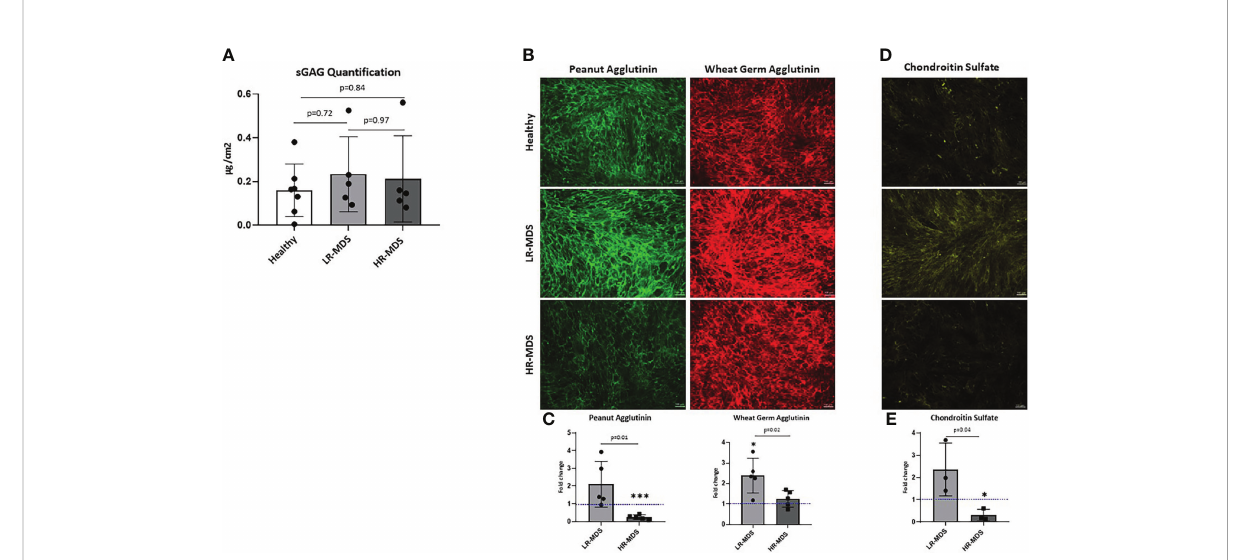
FIGURE 2 Analysis of N -acetyl-glucosamine and N -acetyl-galactosamine GAGs as well as of CS in ECM. (A) Quanti fi cation of sulfated GAGs of ECM from healthy donor, LR-MDS and HR-MDS MSC using Blyscan assay. (B) Representative images from the lectin staining using Wheat germ agglutinin (green) which binds to N -acetyl-glucosamine GAGs (HA, heparan sulfate and keratan sulfate) and sialic acid and peanut agglutinin (red) binds to N -acetyl-galactosamine and terminal ß-galactose containing GAGs (CS, dermatan sulfate and keratan sulfate) from each sample group. (C) Semi-quantitative analysis of relative fl uorescence intensity in the immuno fl uorescence images by ImageJ analysis. Bars represent mean ± SD of N=5 MDS samples, each measured in an independent experiment and expressed as fold change relative to the accompanying healthy MSC ECM control, shown by the dotted line with the ordinate value of 1. Signi fi cant differences to the control value as determined by one sample t-test are indicated by an asterisk above the bar: *p< 0.05, ***p< 0.001. and differences between the two MDS groups as determined by unpaired t-test are shown by the p value above the respective bars. (D) Representative images from chondroitin sulfate of ECM from healthy donor, LR-MDS and HR-MDS MSC. (E) Semi-quantitative analysis of relative fl uorescence intensity in the immuno fl uorescence images by ImageJ analysis. Bars represent mean ± SD of N=3 MDS samples measured in independent experiments and expressed as fold change relative to the accompanying healthy MSC ECM control shown by the dotted line at ordinate value 1. Signi fi cant differences to the control value as determined by one sample t-test are indicated by an asterisk above the bar: * = p< 0.05 and differences between the two MDS groups as determined by unpaired t-test are shown by the p value above the respective